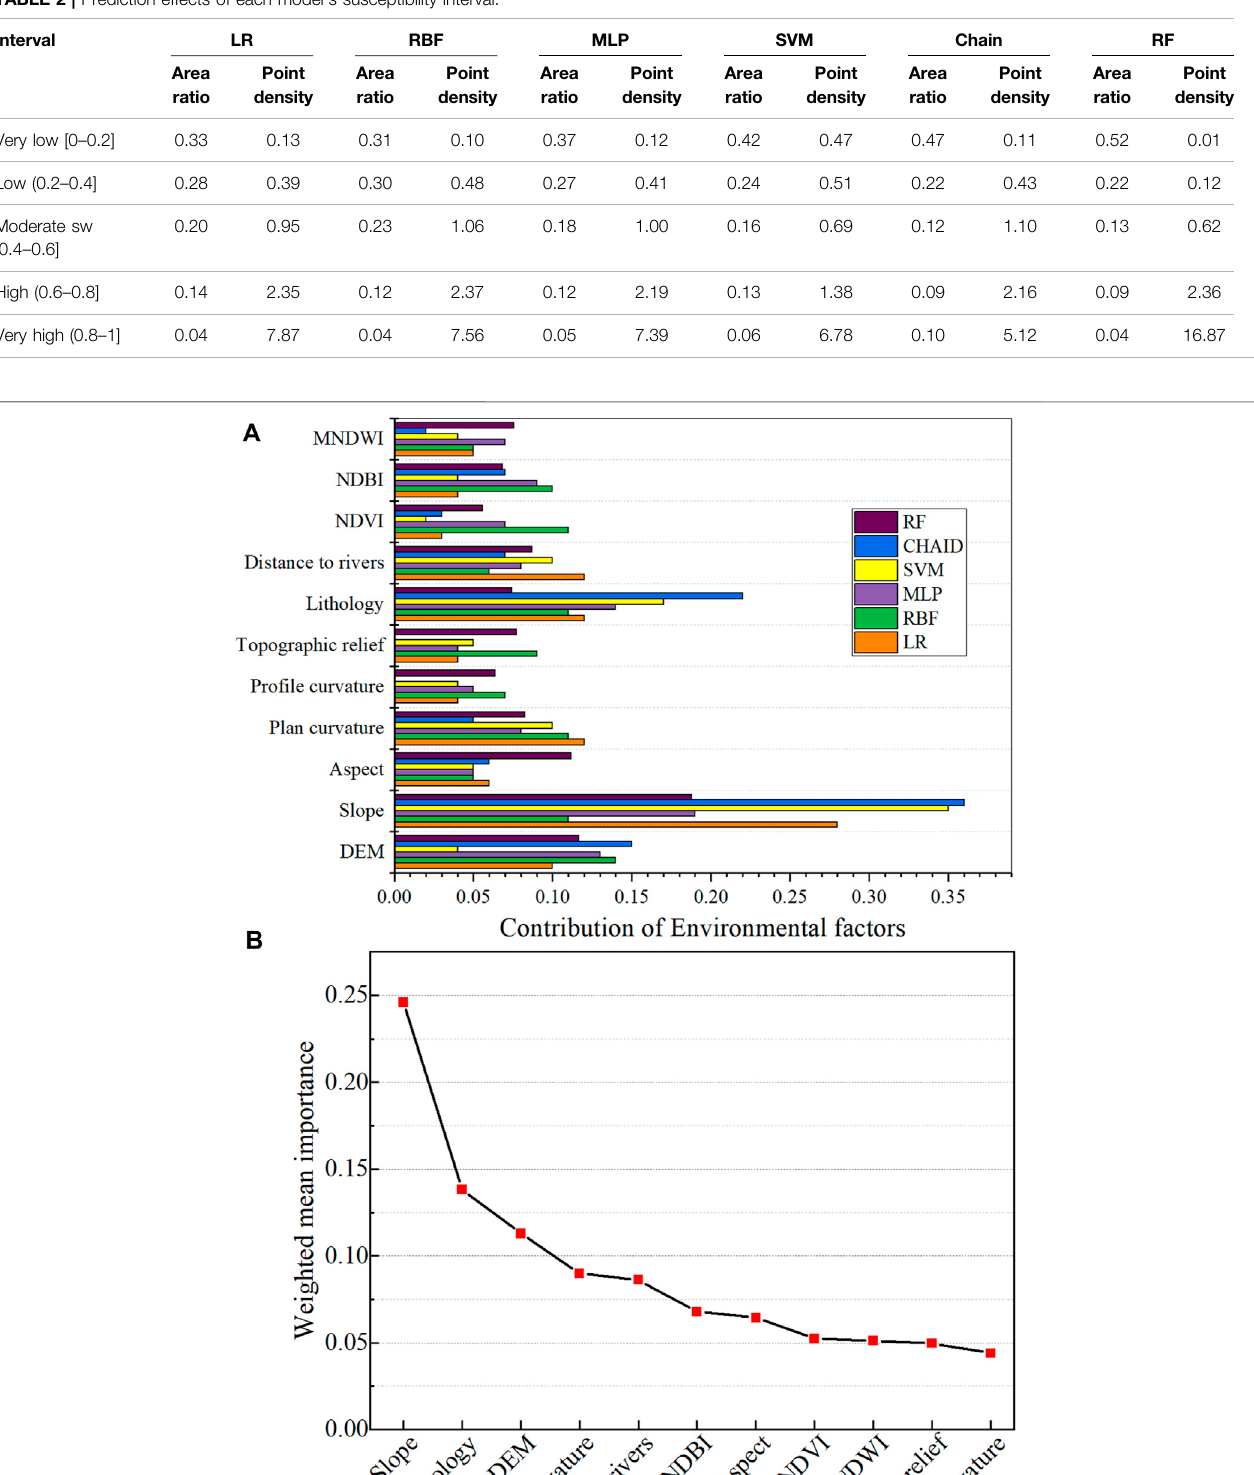
TABLE 2 | Prediction effects of each model ’ s susceptibility interval.